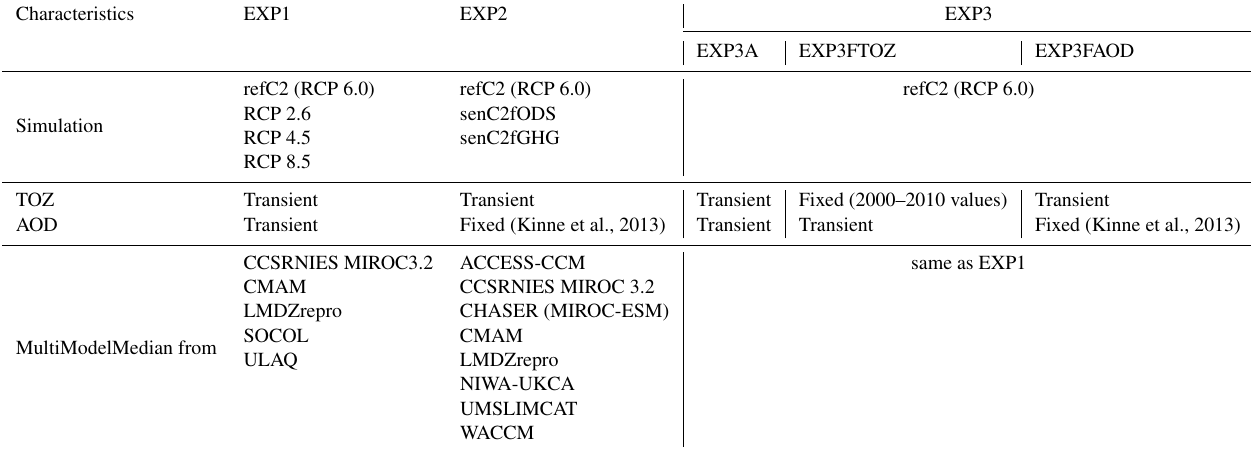
Table 2. Characteristics of the experiment conducted in this study. Simulation: CCMI simulations used in the experiment. TOZ: TOZ evolution throughout the experiment. AOD: AOD evolution throughout the experiment. MultiModelMedian: CCMI Model outputs used for the computation of the median.